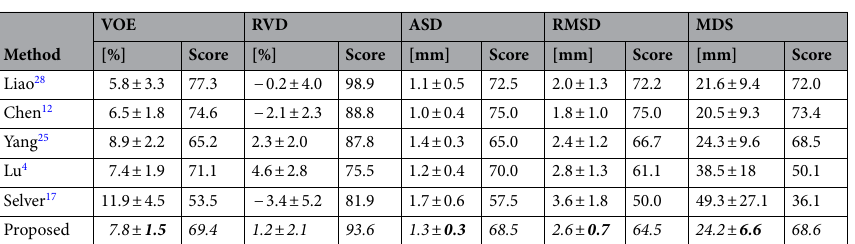
Table 5. Comparison evaluation metrics and score obtained by using different algorithms. The italic means the values obtained by the proposed method. The bold means the best values in each column.